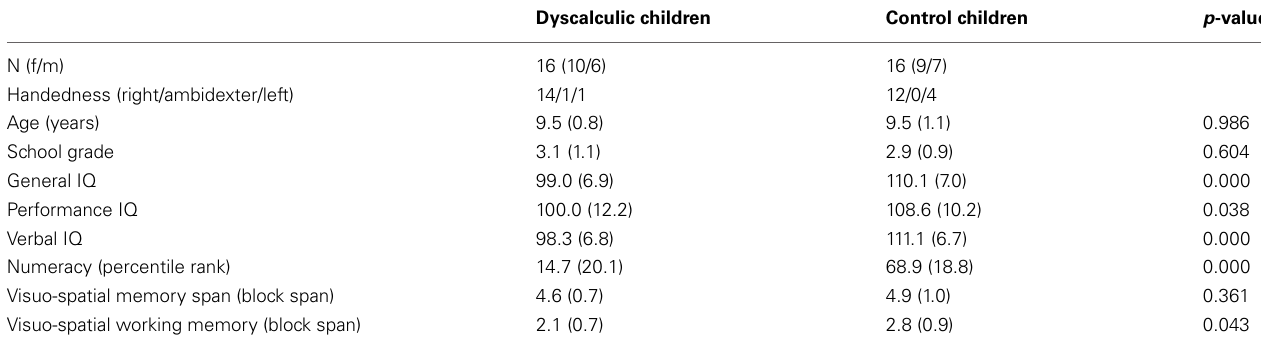
Table 1 | Demographic and testmetric data.